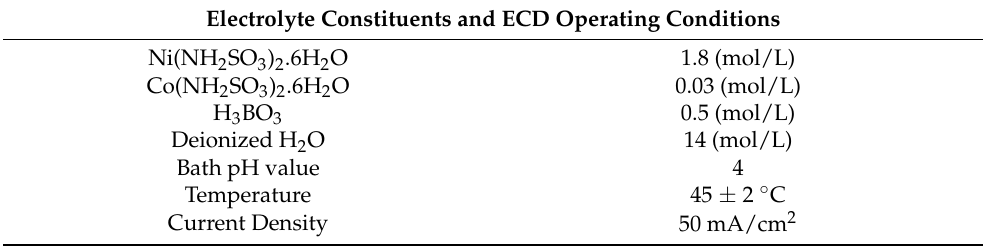
Figure 1. Schematic of conventional electrolytic cell with 3 electrodes, consisting of silicon coated with platinum plating base as cathode, nickel as anode, and Ag/AgCl as reference electrode. The bath hydrodynamics is induced with a magnet bar stirred by a magnetic stirrer. Table 1. Electrolyte composition and ECD operating conditions.